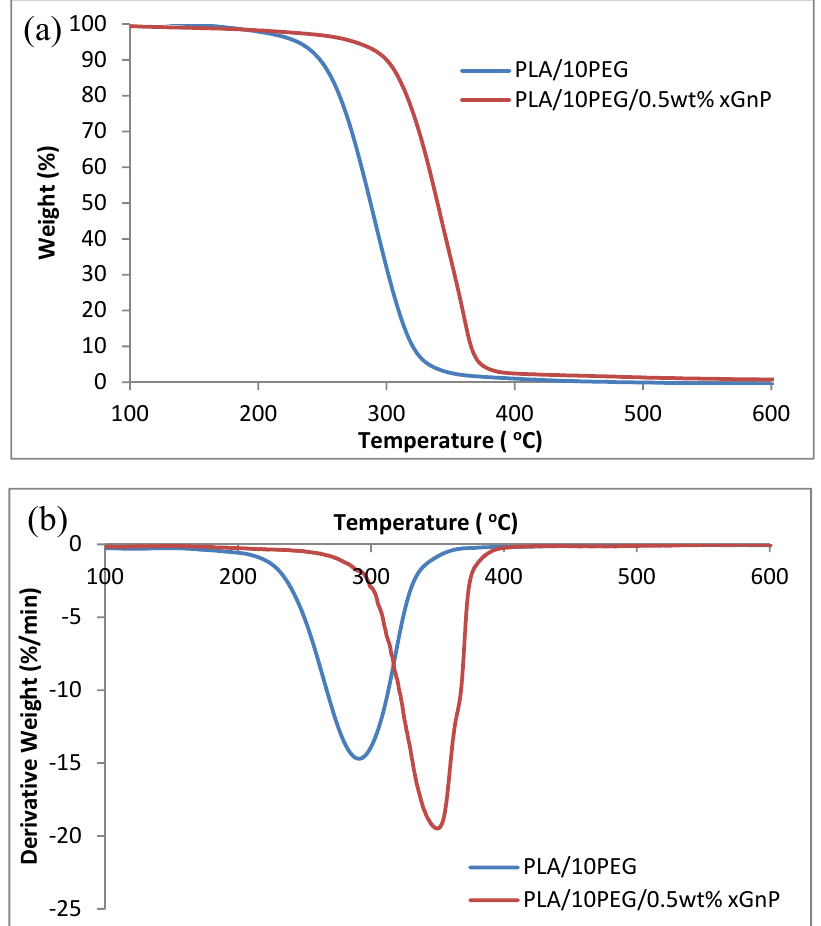
Figure 7. Effect of xGnP on thermal stability of PLA/PEG ( a ) thermogravimetry analysis (TGA) and ( b ) derivative thermogravimetric (DTG)